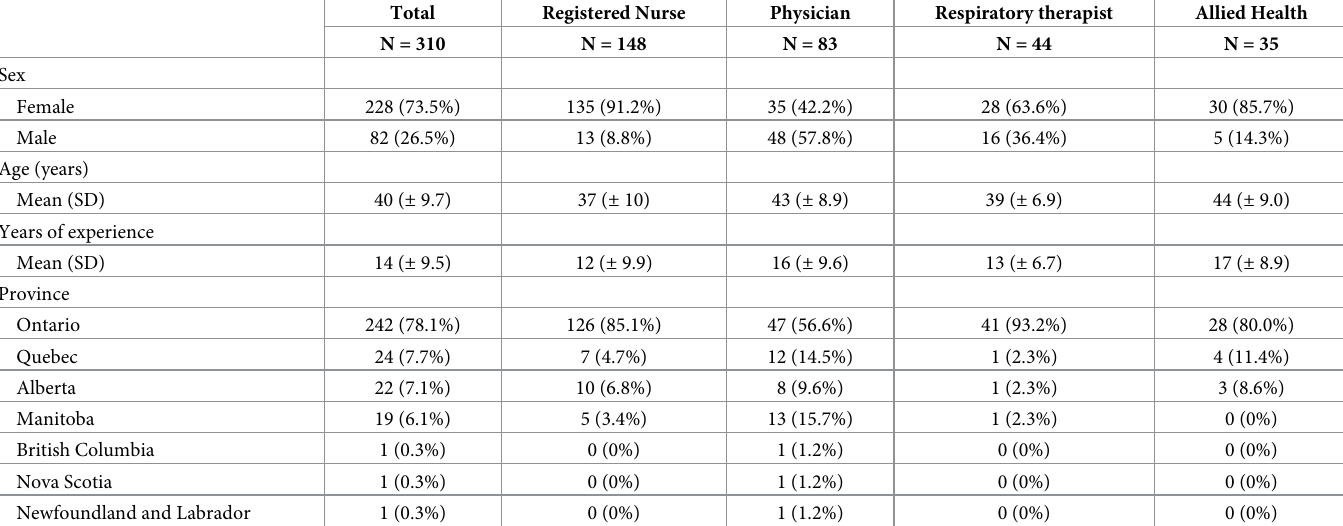
Table 1. Participant